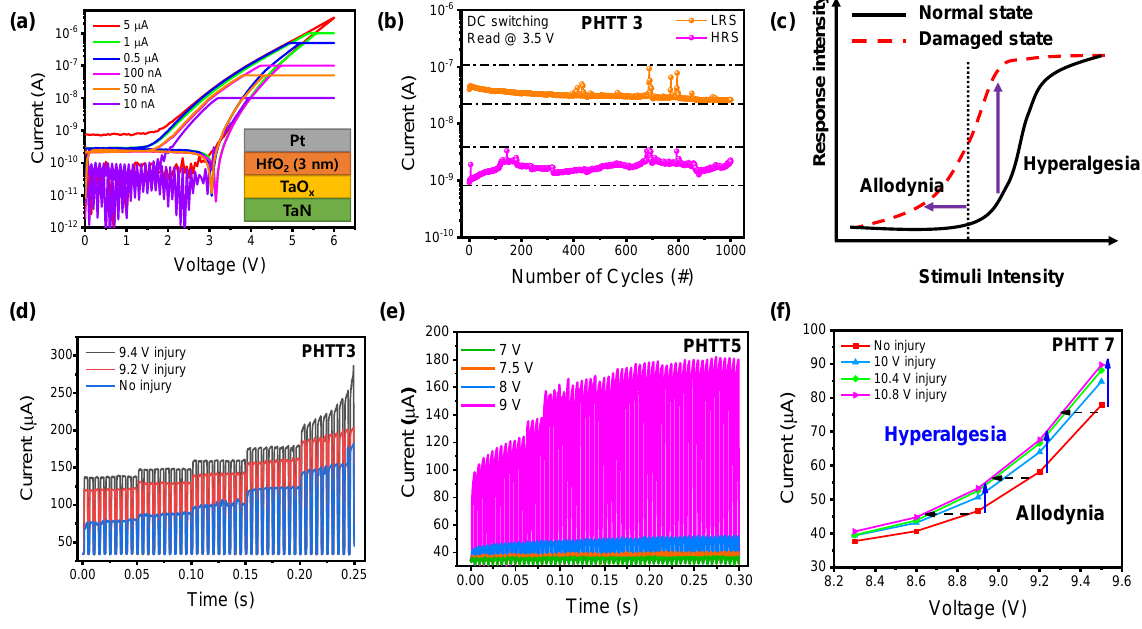
Figure 5. ( a ) TS characteristics of PHTT3 at different I CC . ( b ) DC endurance test of PHTT3 went up to ≈ 10 3 times. Orange dots and pink dots refer to LRS current and HRS current, respectively. ( c ) Typical stimulus versus response relation in the nociceptor in the normal and damaged states. The arrows represent “allodynia” and “hyperalgesia” characteristics. ( d ) Current response according to the voltage in the PHTT3 with and without an injury. ( e ) Current responsivity according to different voltage at PHTT5. ( f ) Experimentally measured current of the PHTT7 before and after the pulse injury, showing the appearance of “allodynia” and “hyperalgesia” characteristics.